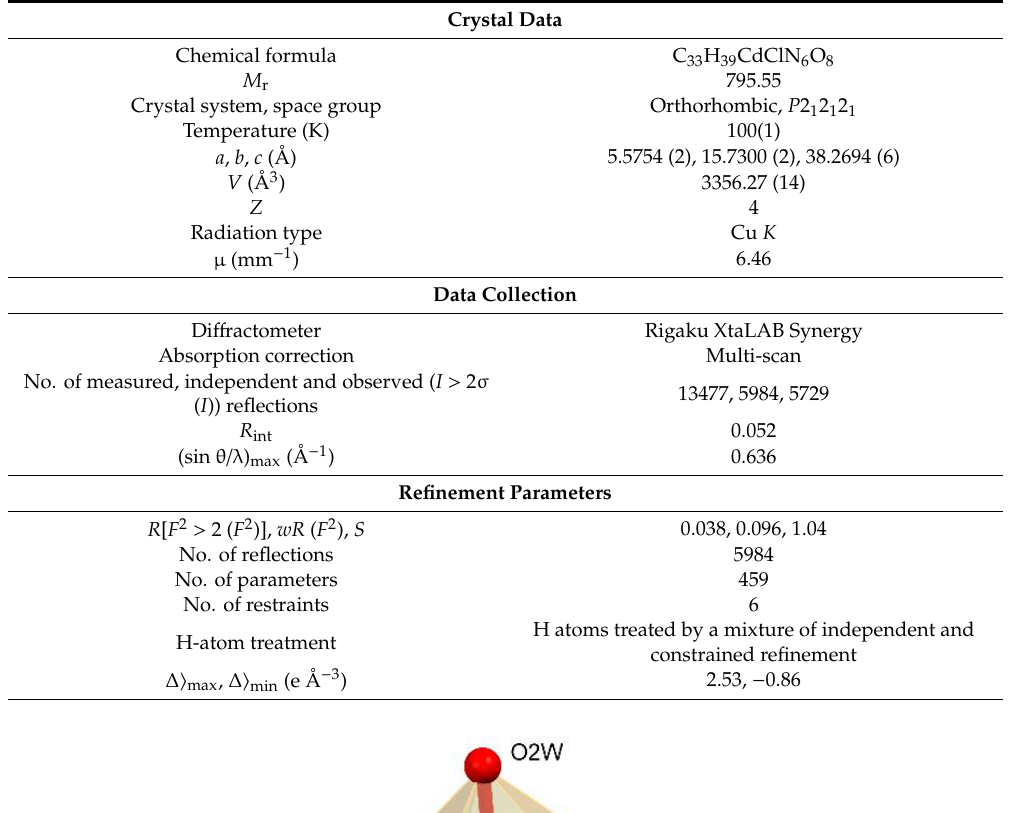
Figure 1. The molecular structure of the complex showing the atom-labeling schemes. Displacement ellipsoids are drawn at the 50% probability level except for the H atoms. Labels A, B and C refer to the symmetrically independent Trp molecules. Table 1. Crystal and structure refinement data for the study complex.